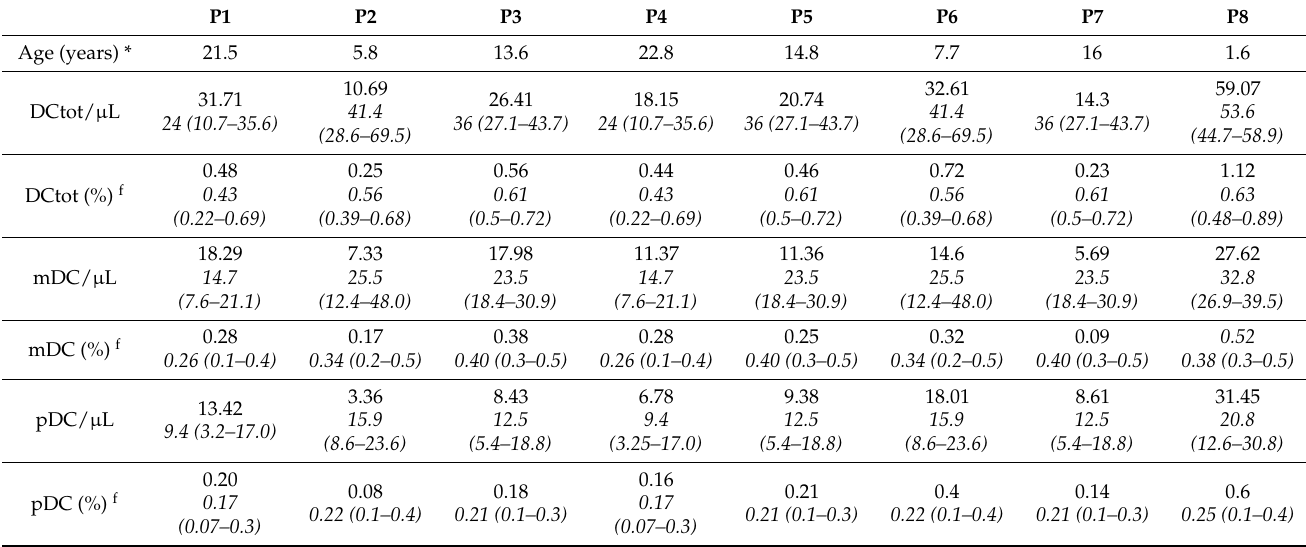
Table 4. Absolute and relative numbers of the dendritic cells in the cohort.